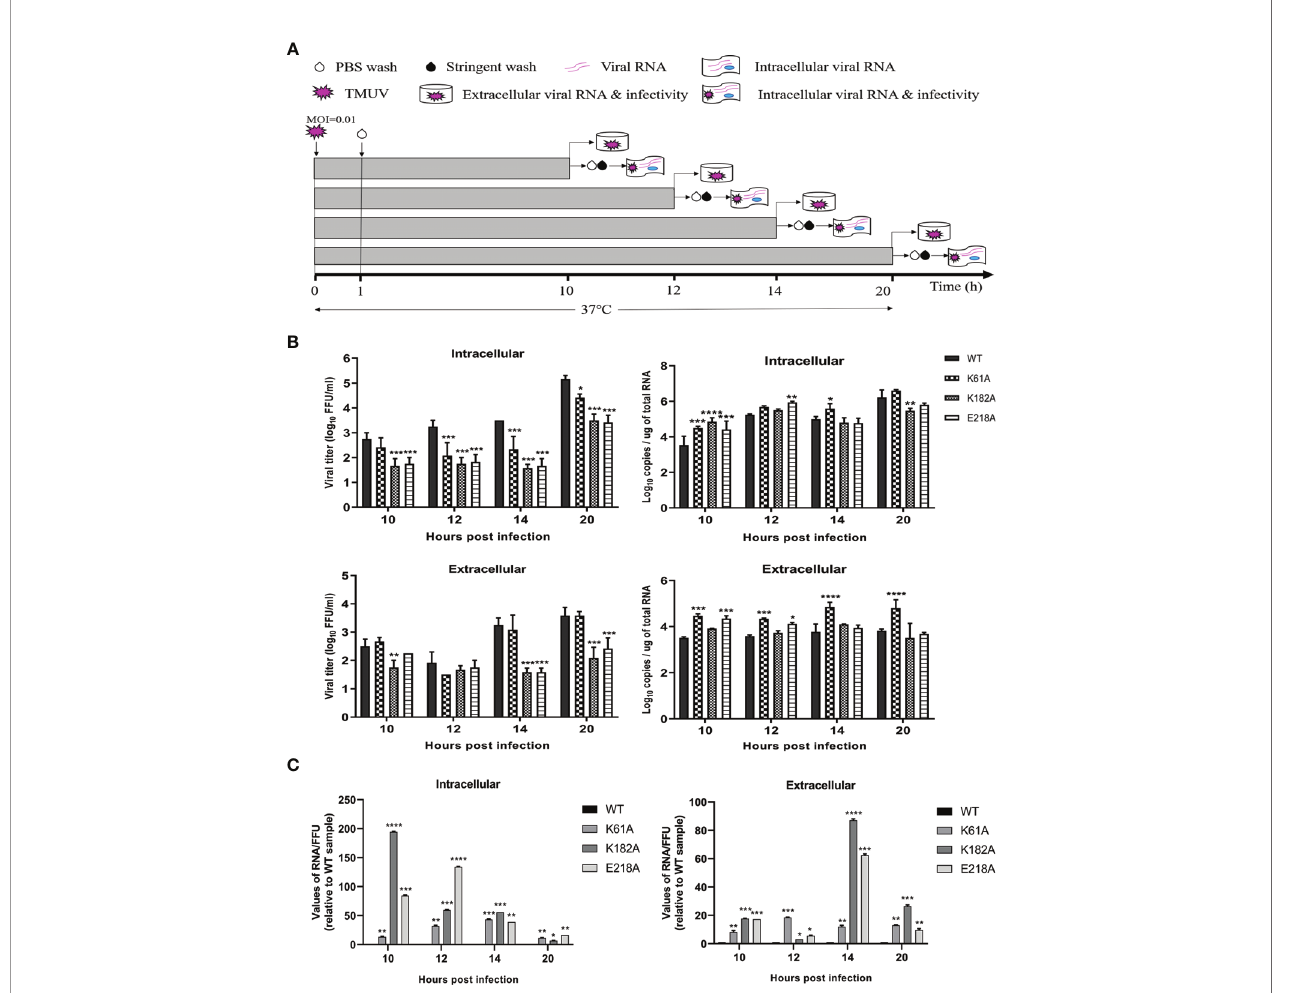
FIGURE 5 | K61A, K182A and E218A mutations inhibit ef fi cient expression of viral proteins. (A) Flowchart of monitoring of TMUV infection. (B) Quanti fi cation of intra- and extracellular infectious virions and viral RNAs at 10, 12, 14 and 20 hpi. At given time points, intracellular and extracellular infectious virions were measured by FFU assay and intracellular and extracellular viral RNAs were quanti fi ed by absolute qPCR. (C) The ratio of RNA/FFU. Each of these was conducted with three parallel replicates. Bars show means ± SDs. **** P < 0.0001; *** P < 0.001; ** P < 0.01; * P < 0.05 (two-way